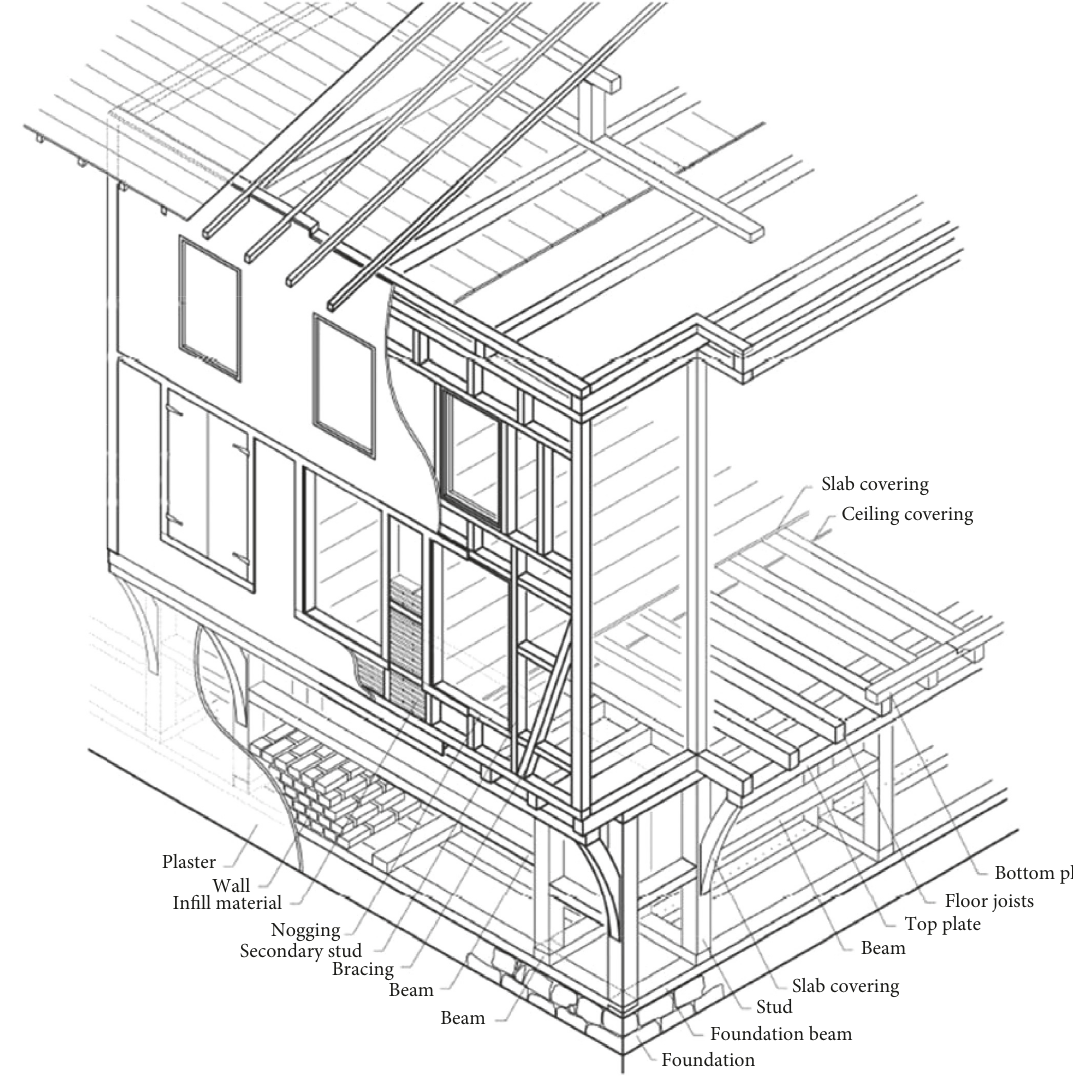
Figure 1: Double-based timber structural system